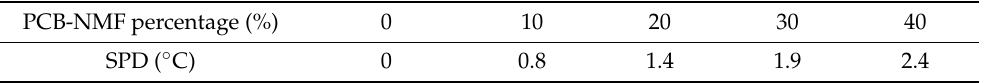
Table 3. SPD of asphalt with different PCB-NMF